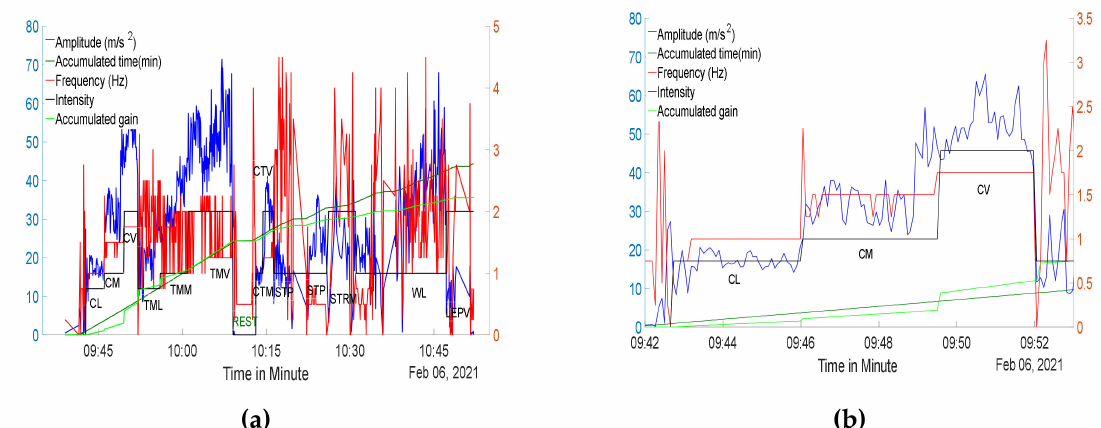
Figure 3. ( a ). Identification of rest and physical exercises at different intensities using amplitude and dominant frequency measures. Exercise intensity and accumulated credit gain throughout Figure 3; ( b ) shows the time windows for cycling activity at low, moderate, and vigorous